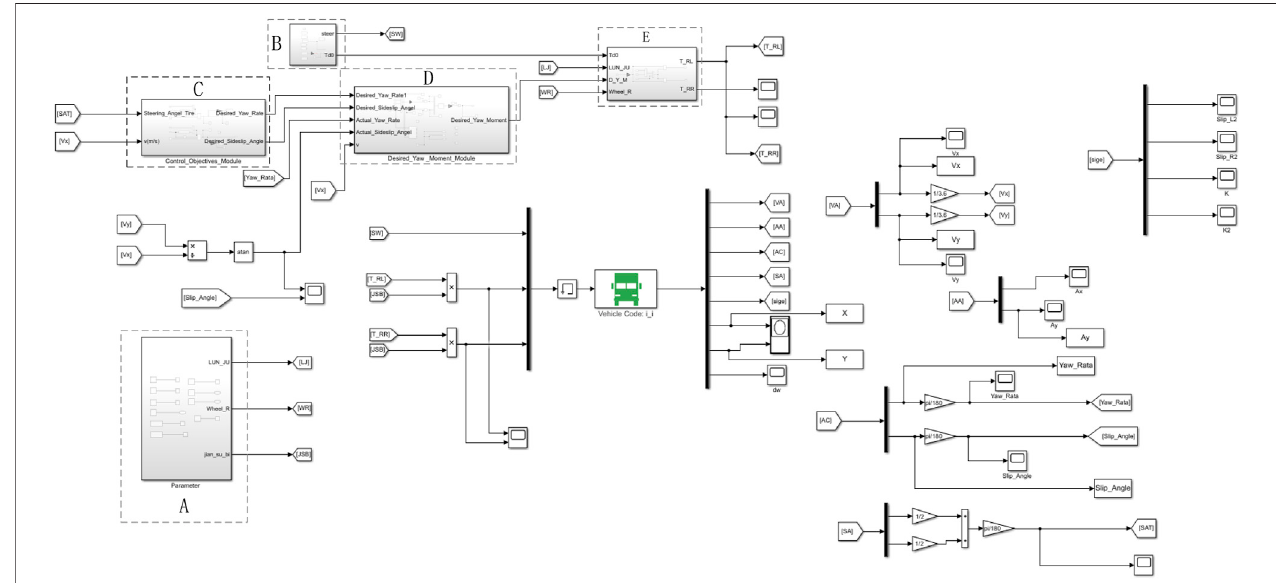
FIGURE 6 | Matlab/Simulink-TruckSim co-simulation platform.